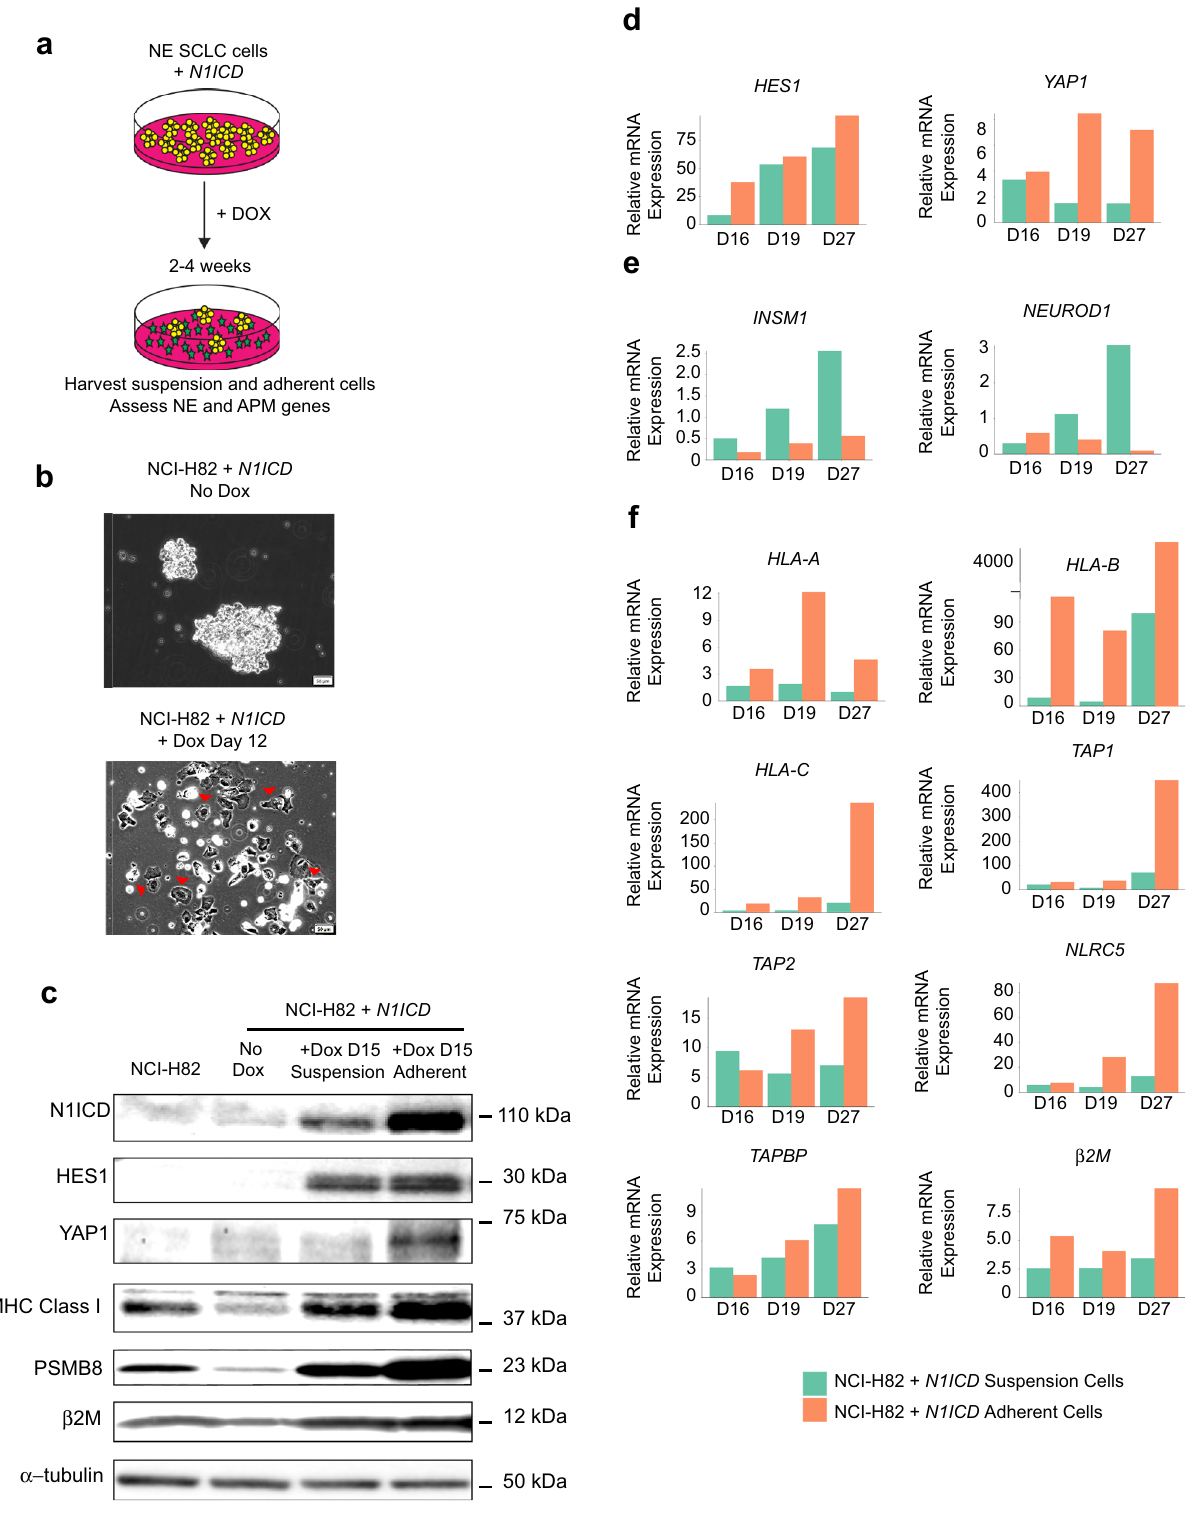
Fig. 5 Overexpression of NOTCH1 intracellular domain in small cell lung cancer induces a high neuroendocrine to low neuroendocrine transition marked by upregulation of antigen processing and presentation genes. a Experimental design to assess neuroendocrine (NE) and antigen processing and presentation (APM) markers in suspension and adherent cells after NOTCH1 intracellular domain ( N1ICD ) overexpression. b Bright fi eld microscopic images of NCI-H82 suspension and adherent cells. Red arrows point to examples of adherent cells. c Immunoblot analysis of Notch pathway, NE and immune proteins after N1ICD activation for 15 days. Expression of downstream d Notch and YAP pathway, e NE and f APM transcripts. Bars indicate mean of three technical replicates. The data are presented as fold change compared with non-doxycycline treated cells. Three biological replicates at 16, 19, and 27 days after N1ICD overexpression are shown. Source data are provided as a Source Data fi